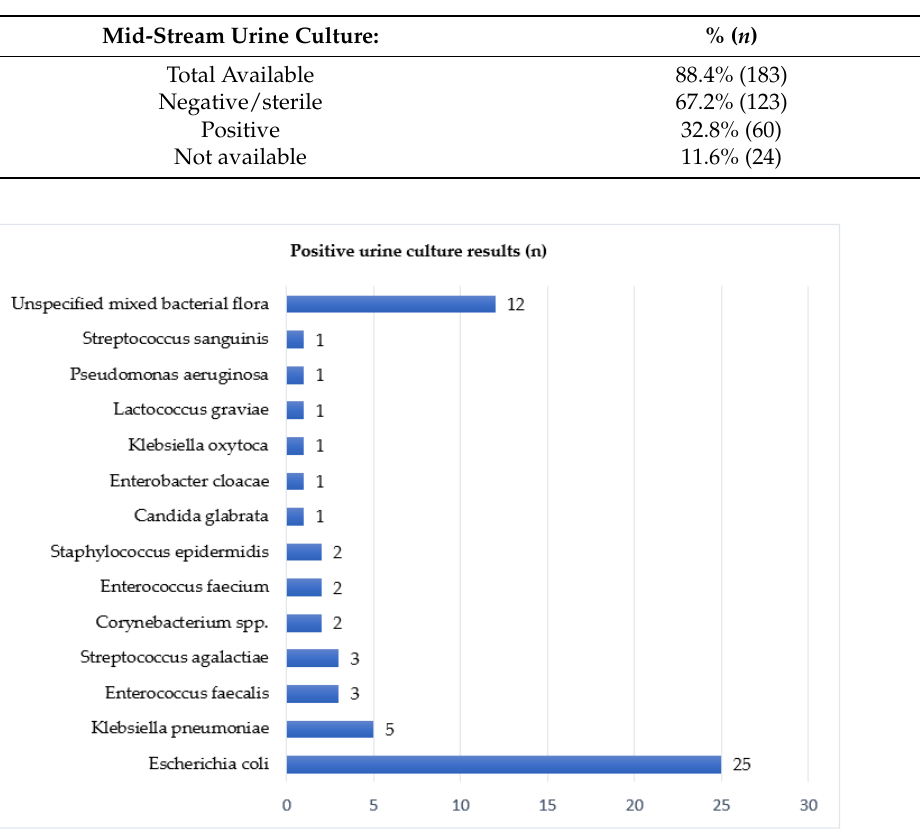
Figure 1. Positive urine culture results.